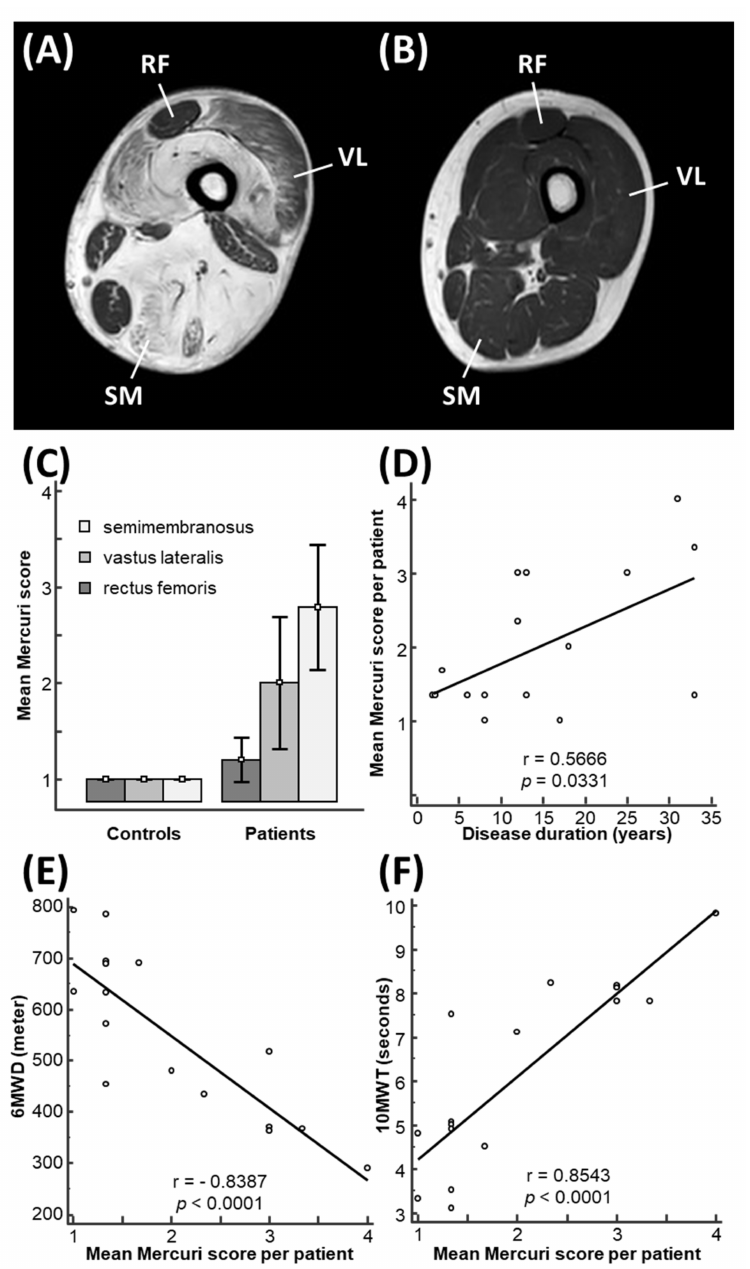
Figure 1. Mercuri score is correlated with functional outcomes in LGMD-R12 patients. ( A ) Axial MRI section through the left thigh of patient 6, indicating the differential involvement of the target muscles: rectus femoris (RF) with Mercuri score 1, vastus lateralis (VL) with Mercuri score 3 and semimembranosus (SM) with Mercuri score 4. ( B ) A similar axial MRI slice of a control individual is shown. All muscles in healthy controls are per inclusion criterion normal and thus have a Mercuri score of 1. ( C ) Mean Mercuri score for all patients and for all controls is shown for the three target muscles. The bars indicate the 95% confidence interval. ( D ) A significant correlation between the mean Mercuri score per patient (dots) and the disease duration is shown in a scatter diagram, with “r” indicating the Pearson correlation coefficient, and “ p ” the p -value. ( E , F ) Scatter diagrams illustrating a significant increase in the Mercuri score with decreasing 6MWD ( E ) and with increasing 10MWT ( F